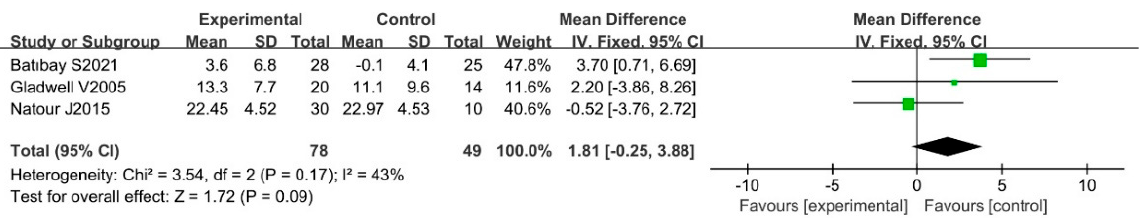
Figure 9. Meta-analysis of the effect of Pilates on the sit-and-reach test in CLBP patients [21,48,53].